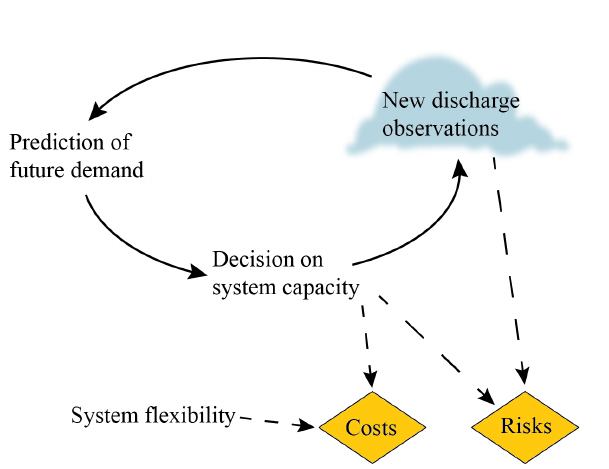
Figure 2. Schematic sequential planning process: after an initial decision on system capacity, new observations lead to an altered prediction of future demand and thus potentially adjustment. At the same time, the future discharges cause damage (i.e., in their ex- pected form, risks) depending on the capacity in place. The cloud signifies that future discharges are uncertain. Costs of decisions de- pend on system flexibility. Adapted from Špaˇcková et al.